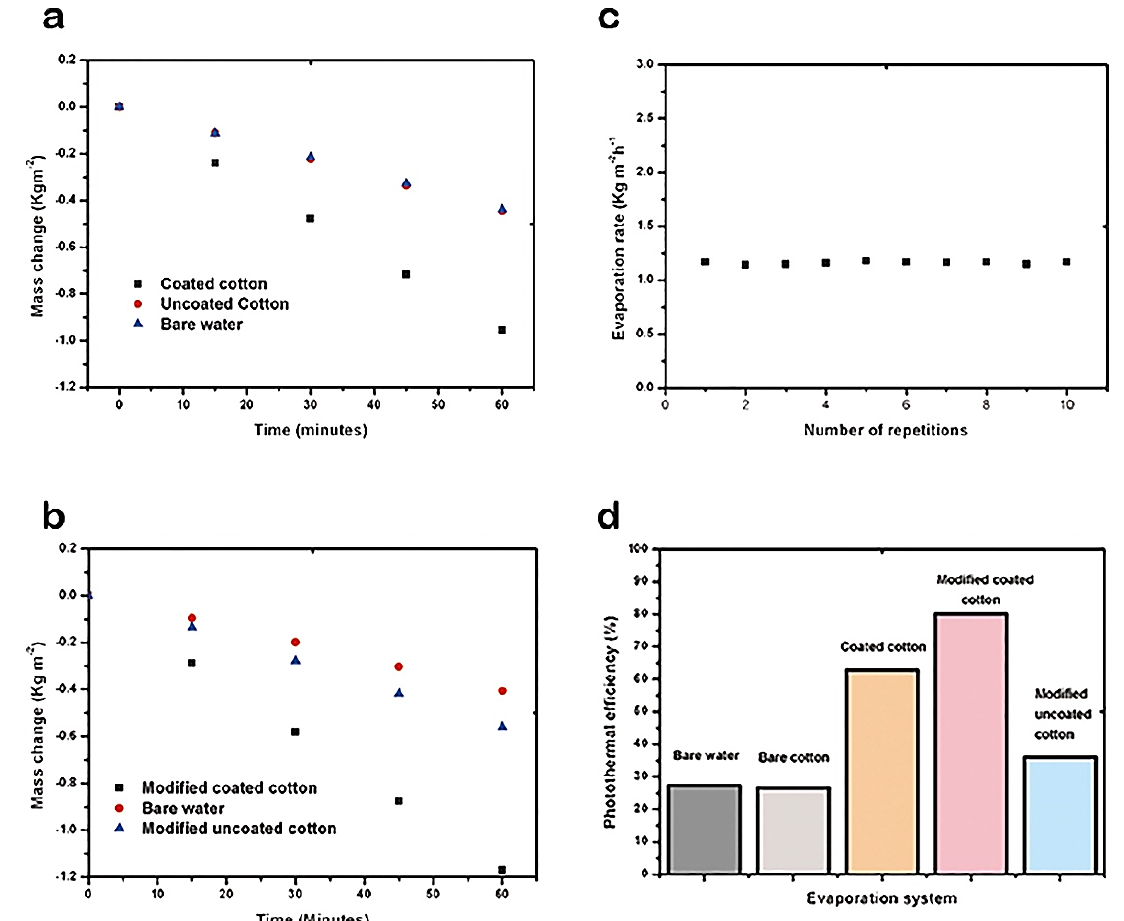
Figure 10. Comparing the performance of plasmonic-modified and non-modified cotton membranes based on the studies performed by Wilson et al.: ( a ) evaporation performance of different systems on the changes in the mass of liquid water; ( b ) performance of the plasmonic-modified system based on the rate of evaporation; ( c ) stability of the plasmonic-modified system in case of the rate of vapor generation; and ( d ) efficiency of different photothermal vapor generation systems. Reprinted with permission from [138]. Copyright © 2019, Elsevier.